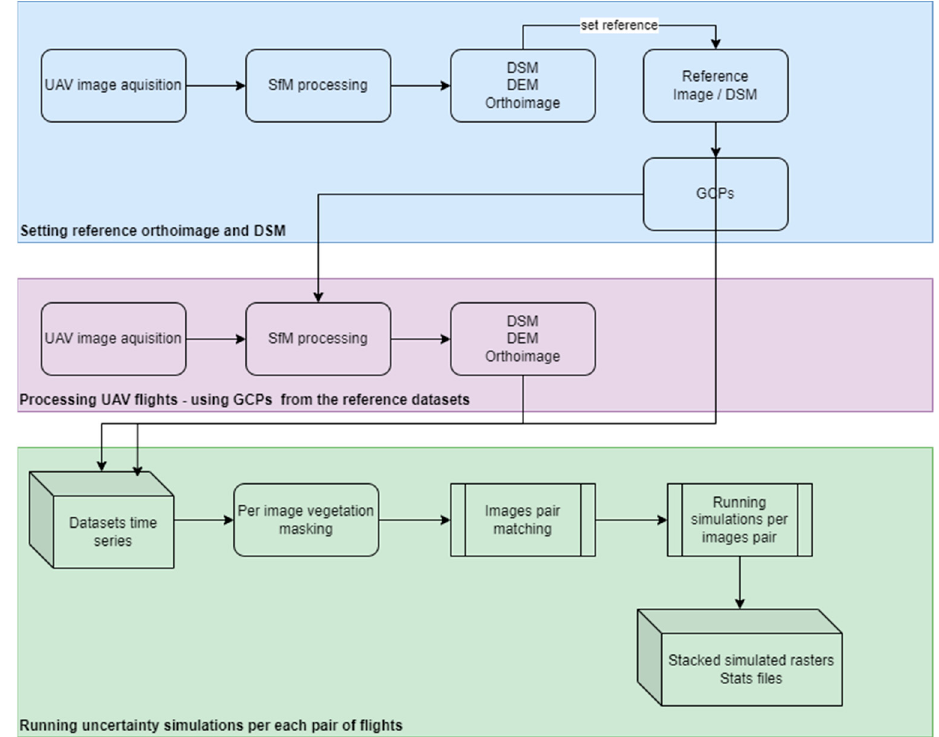
Figure 6. Methodological workflow for mapping landslide displacements using aerial imagery time series.